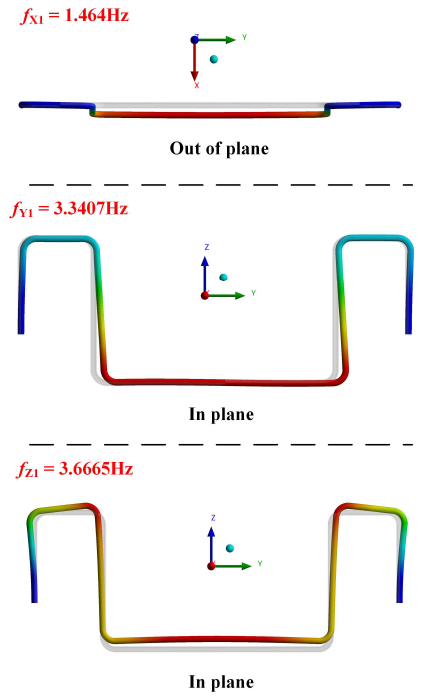
Figure 3. The fundamental modal shapes and associated natural frequencies along the three coordi- nates, where f x1 , f y1 and f z1 are the first natural frequencies in the three directions. The employed numerical model is validated against the reported experimental results of an air-water flow-induced vibration of an inverted U-shaped jumper [33]. A high- speed camera was used in that study to capture the flow evolution in the test and laser displacement sensors were employed to record the vibration displacements of the upper right bend in three directions. Figure 4 compares the calculation results through the current numerical model with the reported data. Figure 4a depicts the spatial flow evolution in three instants when hydrodynamic slug flow is injected into the jumper with v air = 0.51 m/s and v water = 0.46 m/s. Figure 4b plots the variation of vibration displacements with the gas void fraction ( ϕ gas ). It is clearly seen that both the two-phase flow regime and the vibration response are in good agreement with the experimental results. Therefore, the present two-way coupling approach could provide an accurate prediction for the MFIV response.